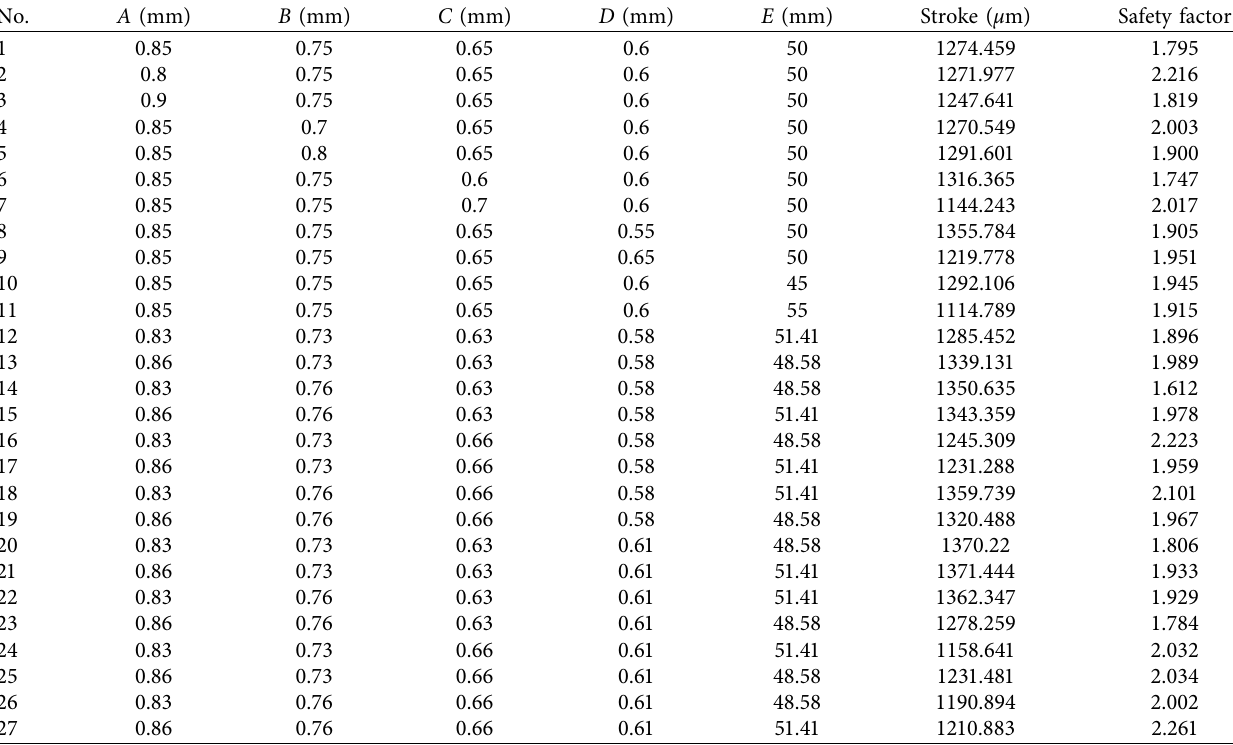
Table 5: Numerical results for the MPM platform.